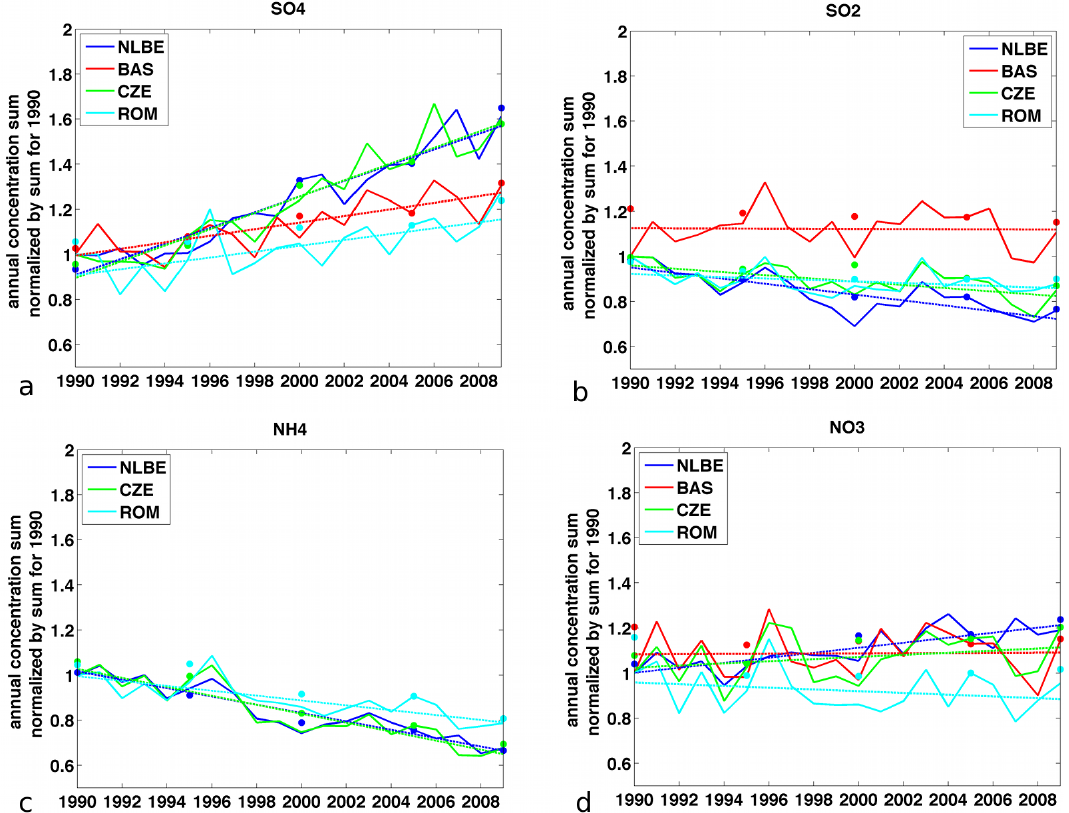
Figure 6. Amount of (a) SO 2 − , (c) NH + and (d) NO − (solid lines) formed from 10kton of SO 2 , NH 3 and NO 2 emissions, respectively, 4 4 3 relative to the amount formed in 1990, for the different labels as indicated by the colours, for the entire time period 1990–2009. Panel (b) shows the resultant SO 2 per unit SO 2 emission for each label for the 1990–2009 time period. The corresponding trend lines are presented as dashed lines. The dots denote results for the runs forced with 2005